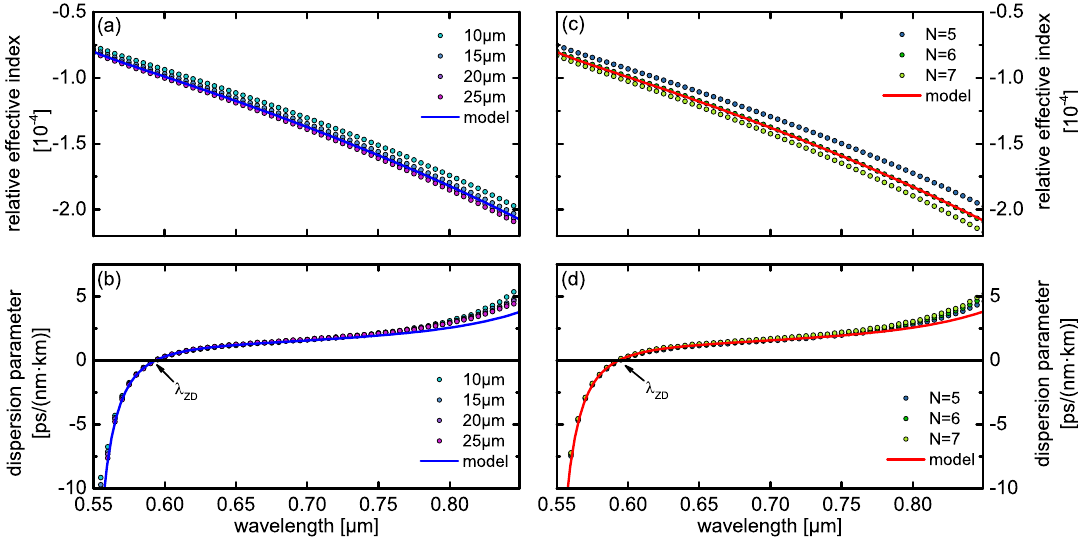
Figure 3. Spectral distributions of the real part of the effective index (top row) and of the group velocity dispersion (bottom row) for ( a,b ) different ARE diameters d ( N = 6) as well as ( c,d ) different numbers of AREs N ( d = 20 µ m). The symbols represent the results from the numerical FEM simulations considering an RTF, whereas the lines are calculated by the analytic TTF model (Equations (1) and (6)) taking into account an effective core radius parameter of f = 1.08). For all data sets, we used 2 R = 30 µ m, w = 0.5 µ m, and material data of silica [36] and argon